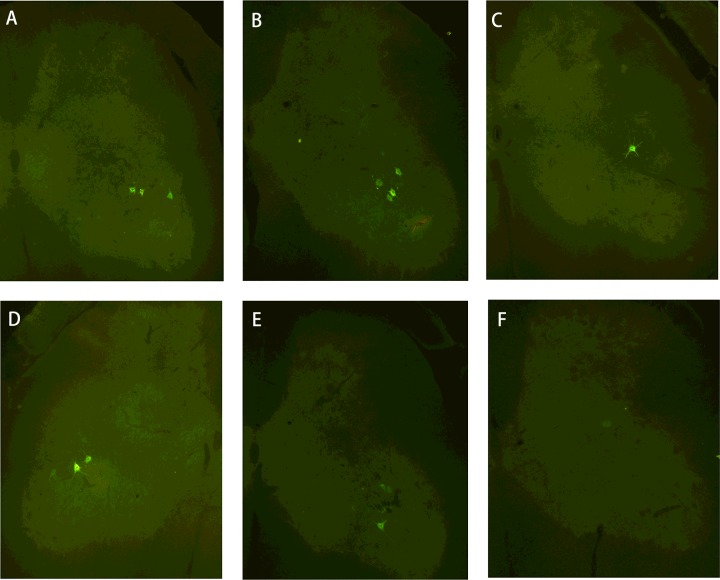
Photographs of CTB labeled motoneurons in three groupsRetrograde labelled motoneruons after injection of CTB in the right GM (green, CTB-labelled motoneurons, magnification ×100). In the non-neurotization groups, CTB-labelled motoneurons were located in the right ventral horn of L4 (A), L5 (B) and L6 (C) spinal cord. In group C, CTB-labelled motoneurons were observed in left (D) and right (E) side of L4 spinal cord but absent from the right L5 ventral horn (F).